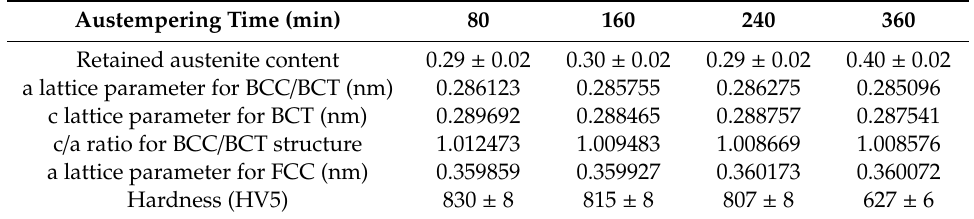
Table 4. Contents of retained austenite, c / a ratio and lattice parameter values for BCC / BCT and FCC structures, and hardness values for samples austempered for 80, 160, 240 and 360